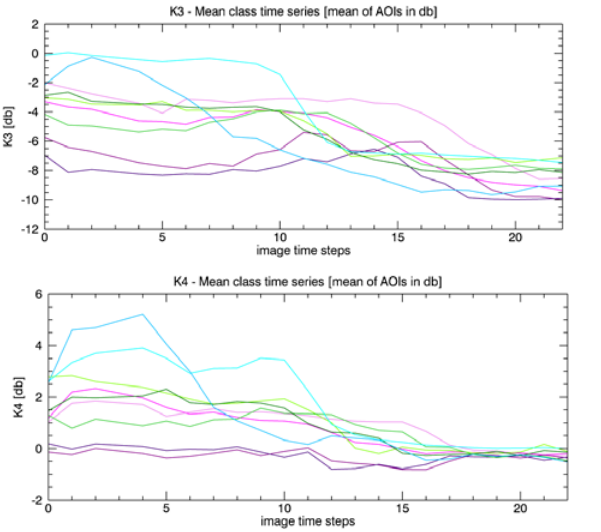
Figure 5. Temporal development of flooded vegetation classes Despite the fact that the single image classification did not have the same success for TerraSAR-X HH-VV and RADARSAT-2 HH-HV images, adding a temporal component presents new opportunities and again highlights the importance of time series for wetland remote sensing (see Figure 6): A multitemporal red- green-blue (RGB) stack of K 0 for TSX (sum of HH and VV intensity), and K 0 for RS-2 (sum of HH and HV intensity) appears promising for detecting temporal changes from both sensors. Both, TSX (X-band) and RS-2 (C-band) are able to capture similar dynamics – in this case considering only the intensity (K 0 ) – however, under the condition that the temporal change is considered. The starting point of the time series (18 October 2014 for TSX and RS-2) is visualized as red channel, resulting in some flooded vegetation on the wetland’s outer boundaries and in the north of Lac Bam being coloured in bright red, and most of the background image being coloured in dark red, due to still present natural vegetation at the end of the rainy Figure 4. Supervised classification applied on the Kennaugh season. An image in the middle of the dry season (25 January elements of (a) TerraSAR-X and (b) RADARSAT-2, both from 2015 for TSX and 22 January 2015 for RS-2) is displayed as 18 October 2014. The classes are: open water (blue), flooded green channel, which causes areas of both, flooded vegetation and irrigated cultivation, appear in light green. An image vegetation (green), irrigated cultivation (red) and non-wetland representing the end of the dry season (15 May 2015 for TSX, 9 (beige). Region A, B, and C contain floating vegetation that was May 2015 for RS-2) is assigned to the blue channel, showing not classified by either of the two sensors. areas where open water retreated at the end of the dry season in dark blue. Rocky and urban areas that are characterized by strong backscatter throughout the whole year appear in light blue to grey and